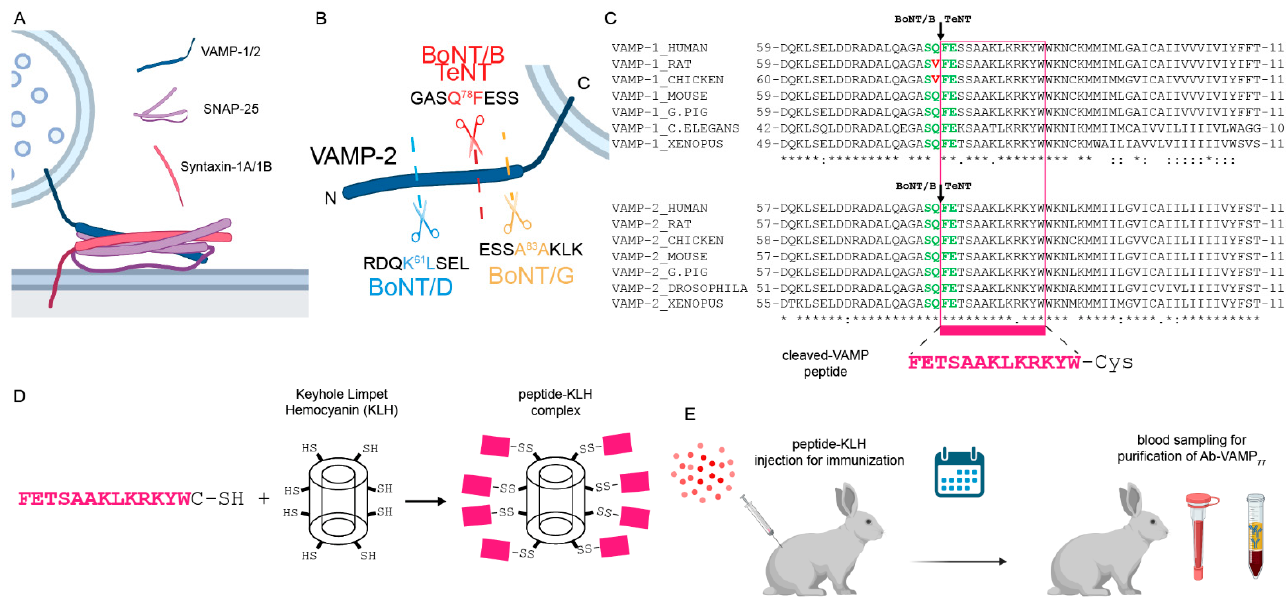
Figure 1. Generation of the Ab-VAMP 77 antibody. ( A ) Scheme showing the three SNARE proteins involved in neuroexocytosis that form the SNARE complex by coil-coiling their SNARE motifs, one from the vesicular VAMP-1/2 (blue), two from the membrane-anchored SNAP-25 (pink), and one from the integral membrane protein syntaxin-1A/1B (red). ( B ) Scheme showing the peptide bonds cleaved by the VAMP-specific CNT used in this study, which generate specific new N-termini to VAMP (shown is human VAMP-2). ( C ) Alignment of VAMP-1/2 showing that the FETSAAKLKRKYW peptide (pink) exposed by BoNT/B and TeNT is in all the main animal species used in research. The green residues indicate cleavage sites of TeNT and BoNT/B in VAMP-1 and VAMP-2. Red residues indicate the mutation responsible for VAMP-1 resistance to TeNT and BoNT/B in rat and chicken. ( D ) Scheme showing the generation of immunogenic carrier by chemical conjugation of the C-terminal Cysteine to the Keyhole limpet Hemocyanin. ( E ) the peptide-KLH complex was injected into a rabbit, and at the scheduled time point the blood was collected for the ensuing purification of peptide-specific IgGs.